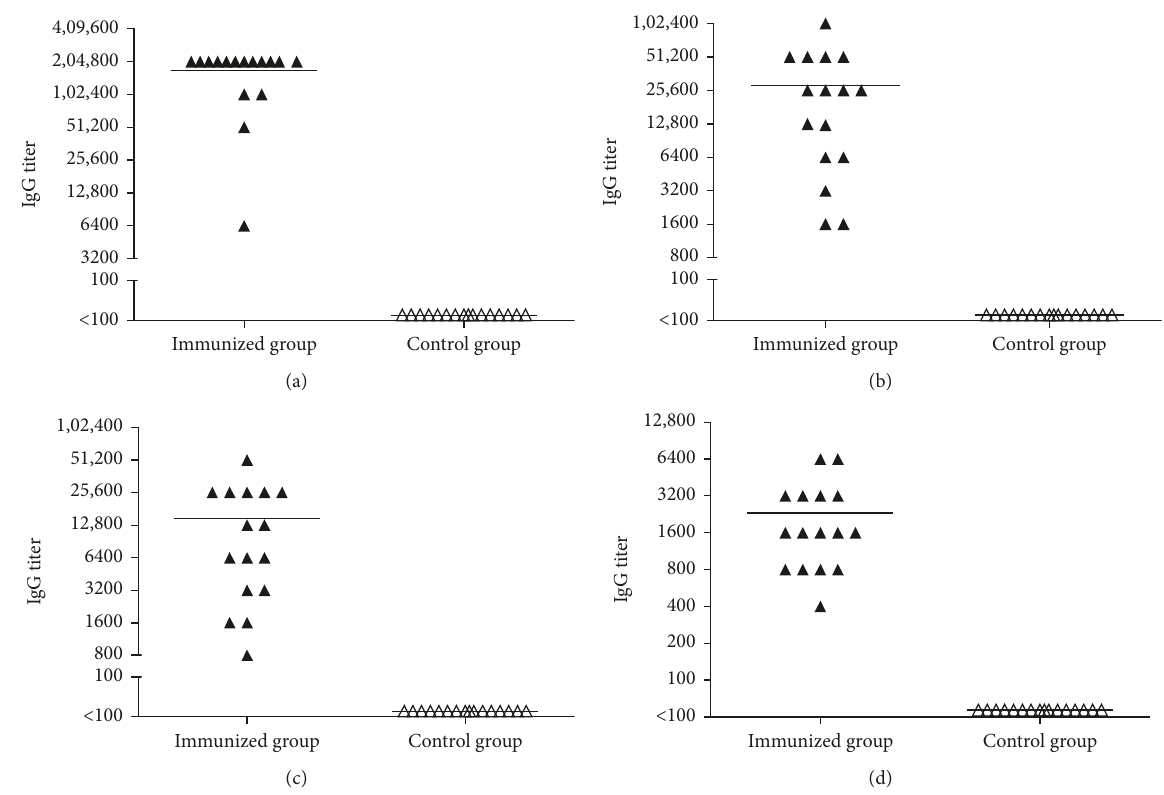
Figure 2: Comparison of serum IgG titers of mice. Sera were collected 14 days after the final immunization. Immunized group mice ( n black triangles) were immunized with 20 μ g peptide vaccine emulsified in Freund’s adjuvant on days 1, 21, 31, and 41. Control group mice ( n 16, open triangles) were immunized with PBS and Freund’s adjuvant on days 1, 21, 31, and 41. Horizontal bar indicates the average (cid:30) antibody responses to the (a) vaccine; (b) M1 peptide; (c) M12 peptide; and (d) J14 peptide. P Table 1: Bactericidal activity of antisera to the divalent vaccine. Serotype